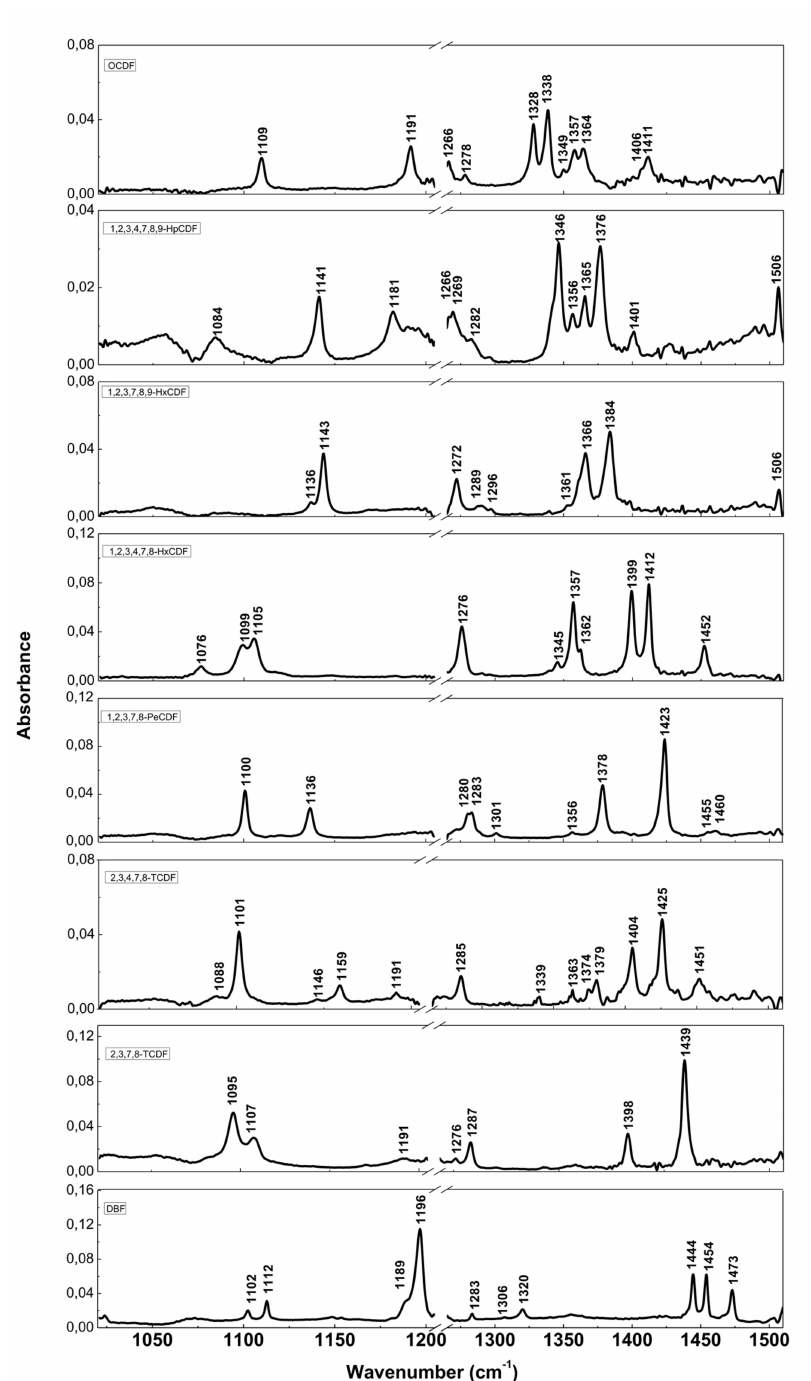
Figure 4. FT-IR spectra of PCDFs and dibenzofuran (DBF). Reprinted with permission from [19], copyright